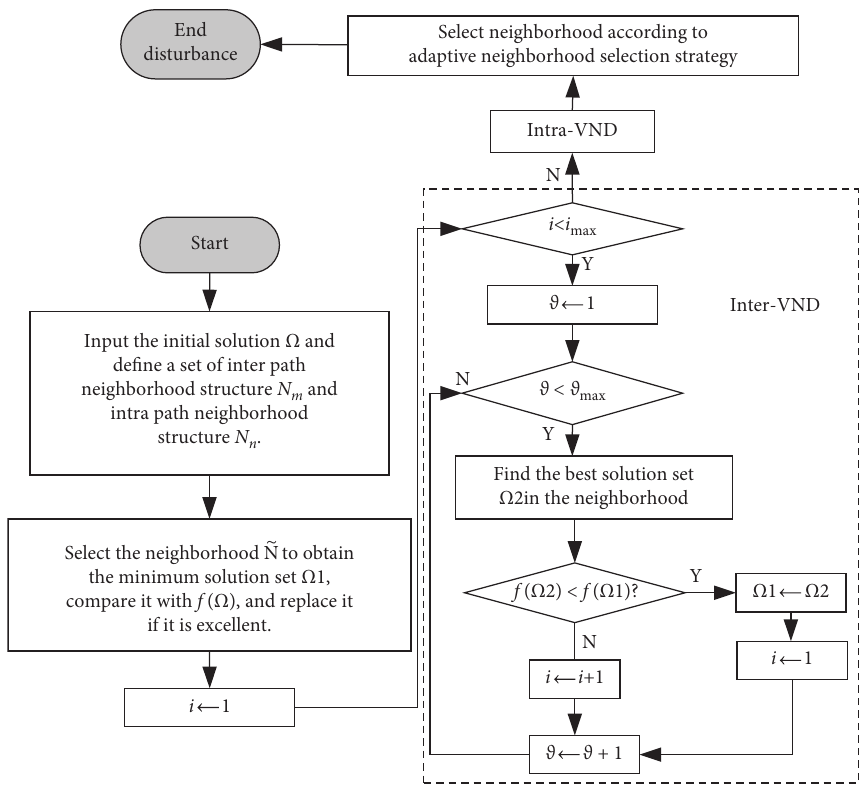
Figure 5: Disturbance search